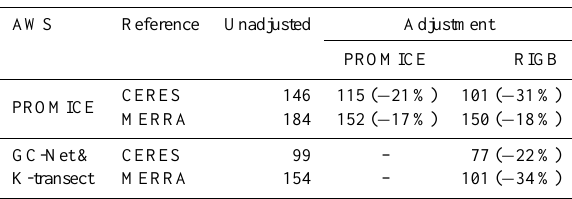
Table 2. RMSE of AWS against the reference data sets under all-sky conditions (Wm − 2